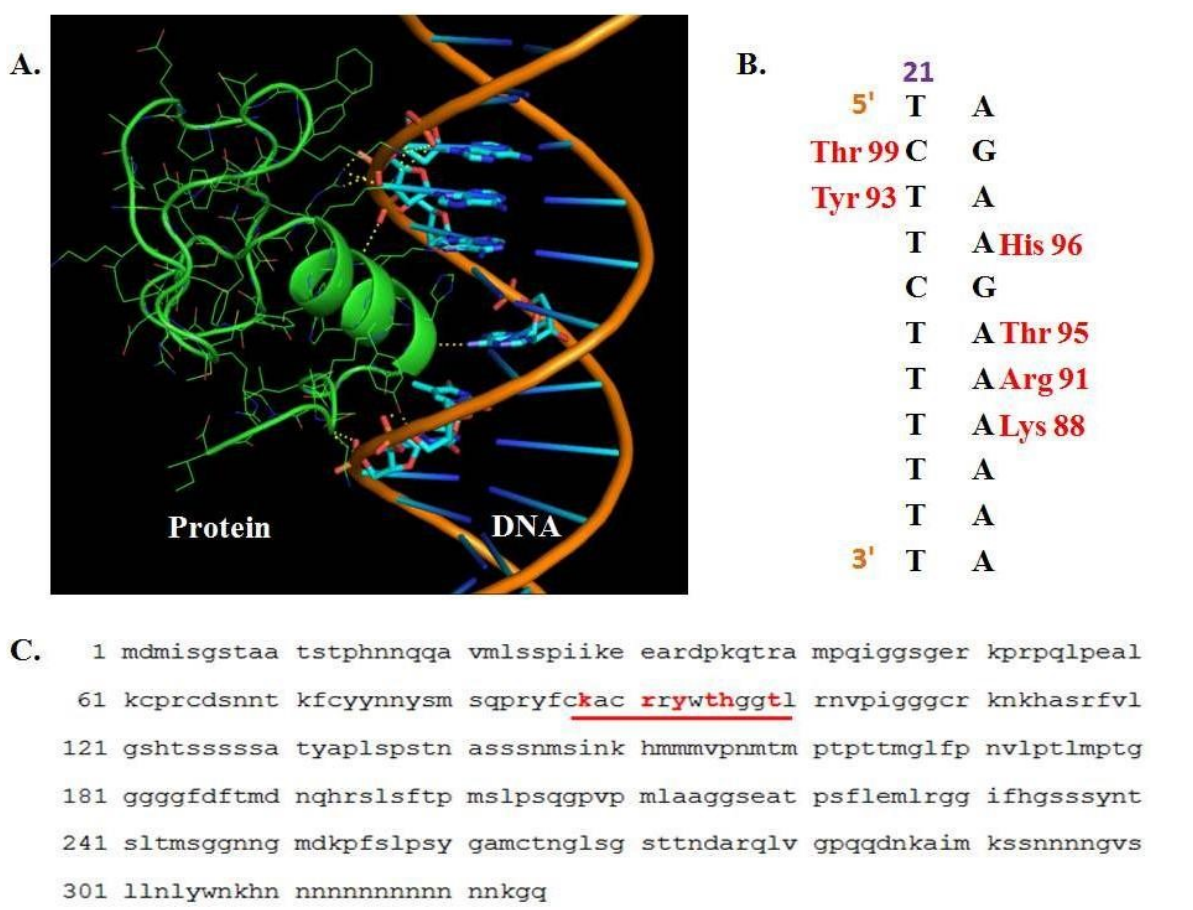
Figure 3. DNA–protein interaction. ( A ). PBF1 partial structure (green) interacting with DNA (orange double helix with nucleotides in cyan). ( B ). Nucleotides and amino acids involved in the interaction. Nucleotides and amino acids are shown in one- and three-letter codes. 5 ′ and 3 ′ ends of the sense strand of DNA have been marked. ( C ). The region of PBF1 that binds phi112 marked DNA has been underlined in red. The amino acids that make polar contact with DNA have been highlighted in red.